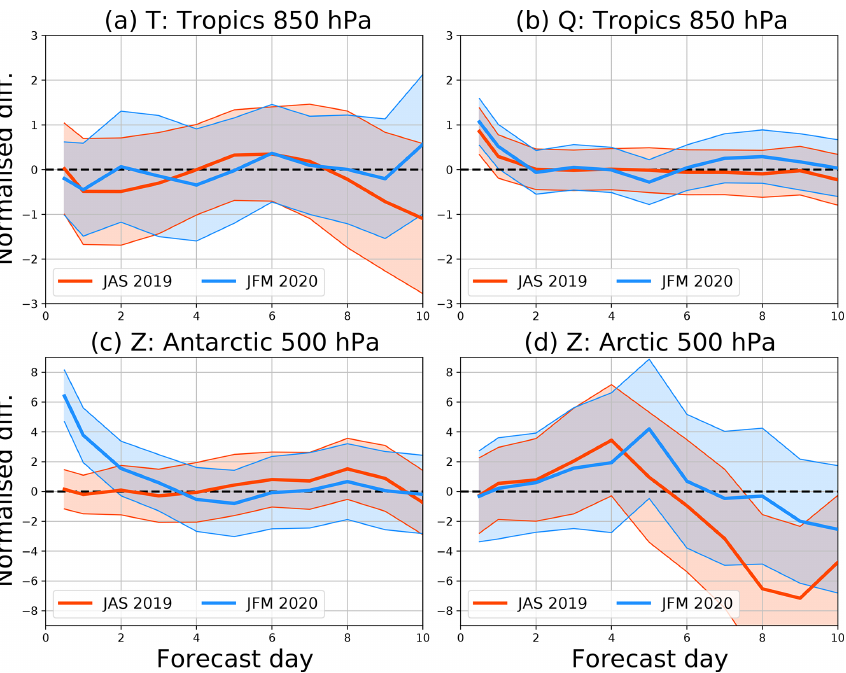
Figure 9. Normalised difference in root mean square error (full line, in %) between the SKTECV and the TOVSCV experiments, when com- pared with the operational analyses, and the associated uncertainty (coloured shading). Red denotes JAS 2019, and blue denotes JFM 2020. See the panel headings for the parameter and region